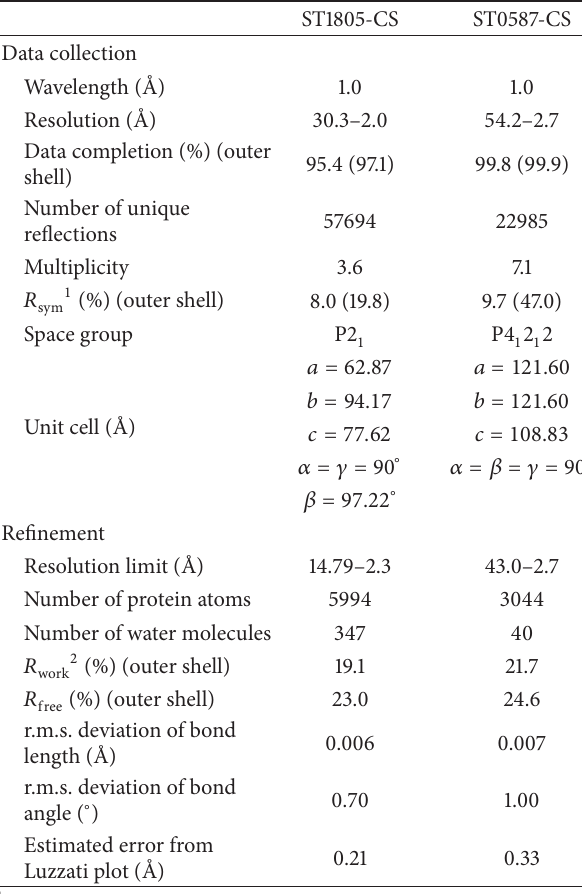
Table 1: Data collection and final refinement statistics. Table 2: Total amino acid